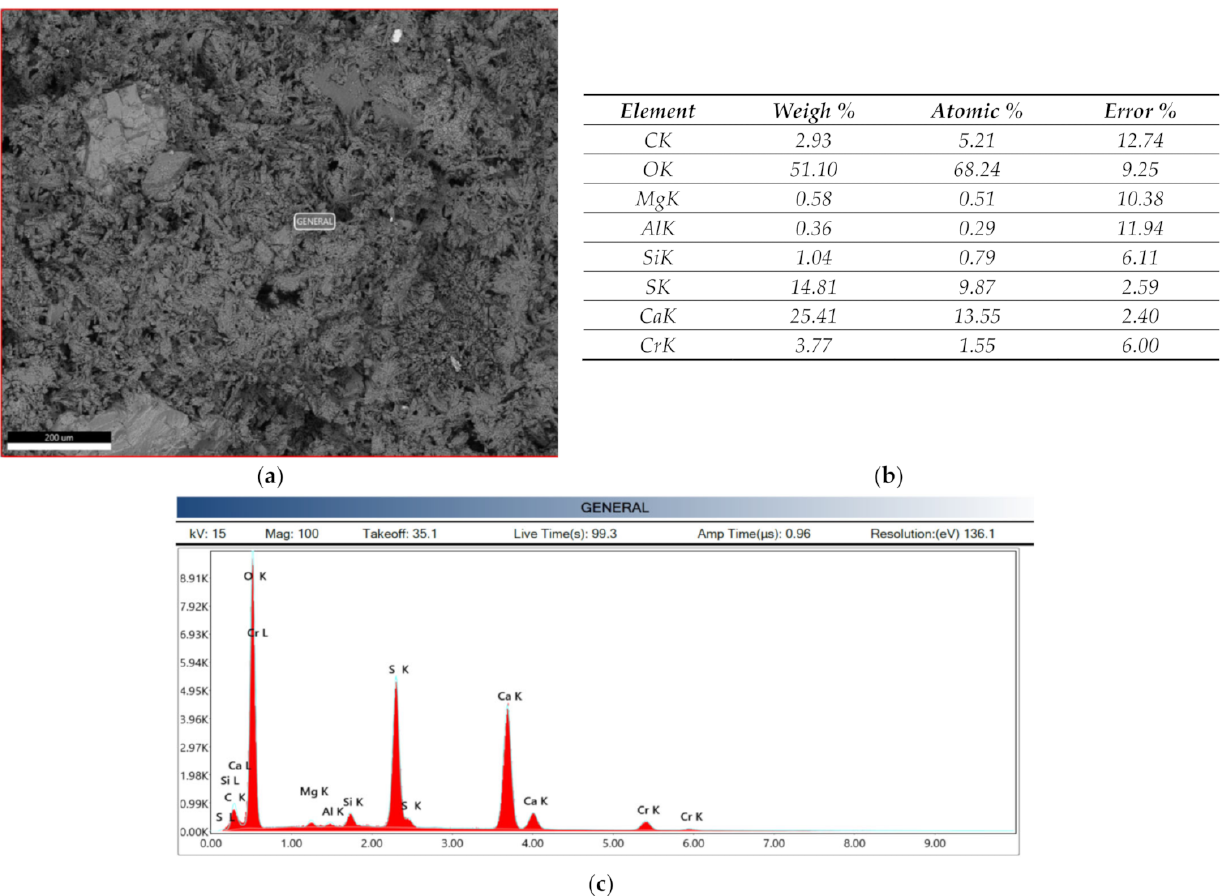
Figure 23. Analysis area and results for the citric acid compound with calcium sulphate, showing the general sample area and X-ray spectrograph (source: the author): ( a ) micrograph of gypsum with citric acid; ( b ) chemical composition; ( c ) chemical composition of gypsum with citric